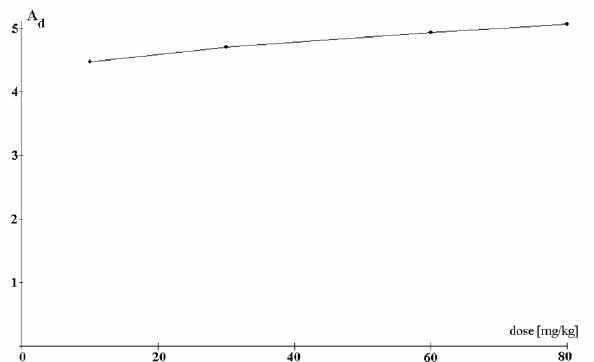
Fig. 5. Resting level A